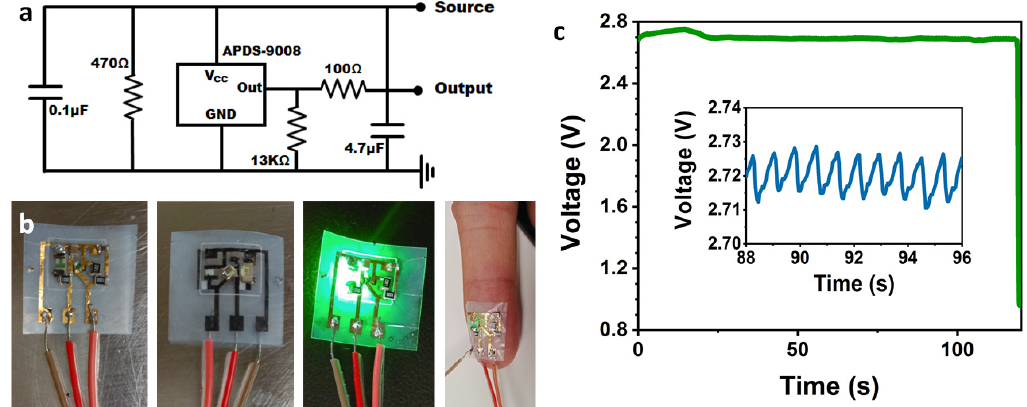
Figure 3. ( a ) Circuit diagram of the heart rate monitor. ( b ) Front (left) and back (middle-left) of the completed heart rate monitor, the device in operation (middle-right), and the device in operation on a finger. ( c ) The green line on the outset graph shows the heart rate measurement of the test subject where the monitor was removed at around t = 119 s, indicating a stable measurement over a lengthy period of time, and clear cessation of operation upon loss of contact to the subject. The inset graph with the blue line shows a magnified view of measurements over a narrow period of time for clarity, with the voltage oscillations corresponding to palpitations.